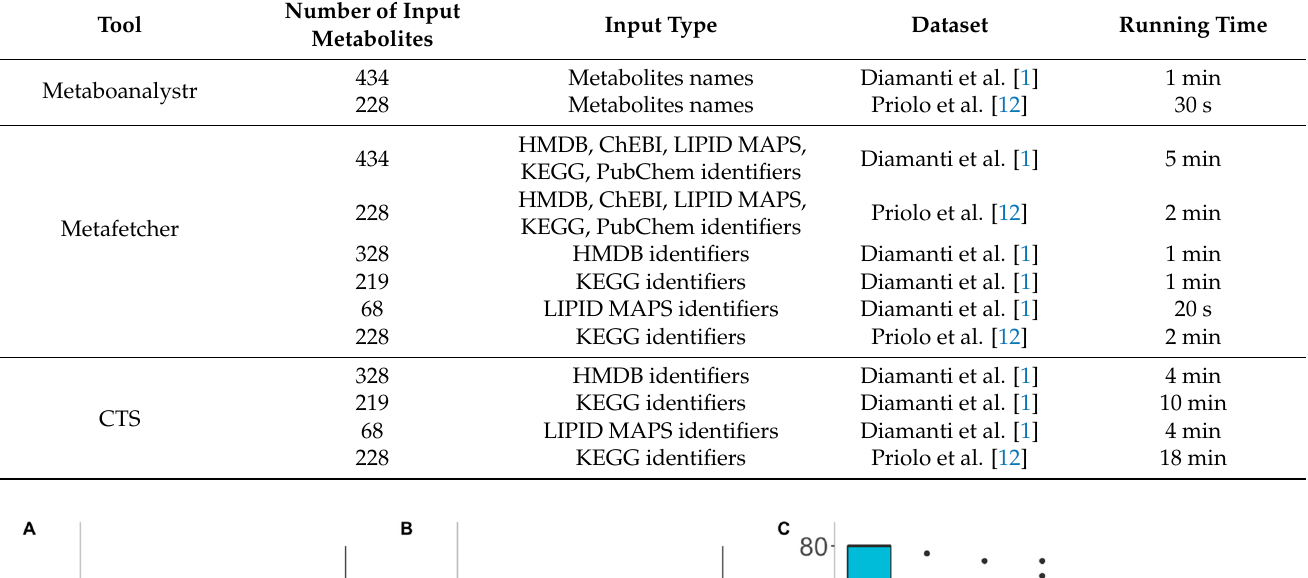
Table 1. Comparison of the running time for MetaFetcheR, MetaboAnalystR, and CTS.